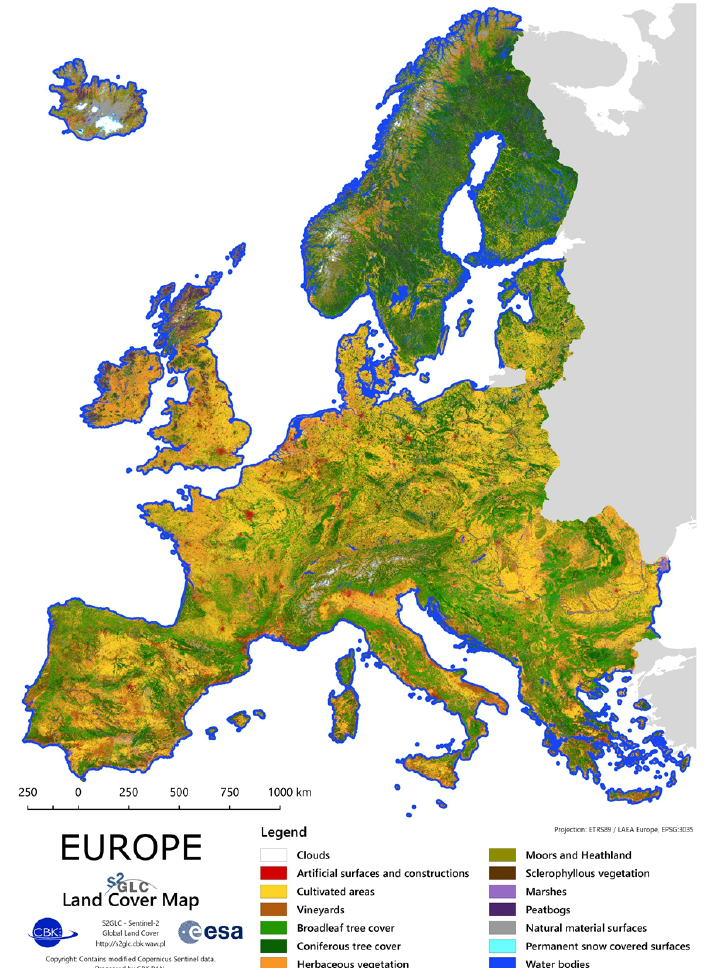
Figure 1. Land cover mapping example. Image taken from ESA (available online: https://www.esa. int/ESA_Multimedia/Images/2020/03/Europe_land-cover_mapped_in_10_m_resolution, accessed on 20 June